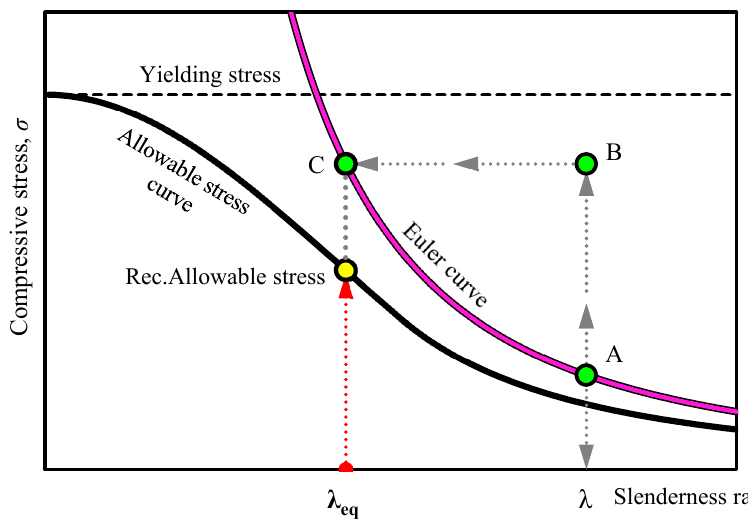
Figure 14. Determination of equivalent slenderness ratio ( λ eq ) and recommended allowable stress for strengthened members.